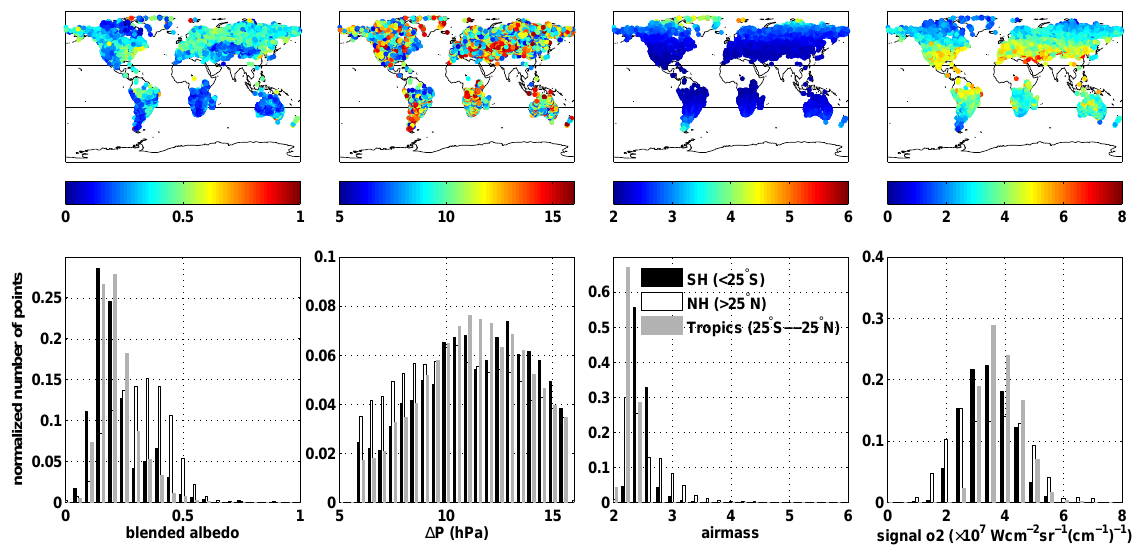
Fig. 8. A map and histogram of the parameters used in Eq. (4) in August. The horizontal black lines on the maps denote the 25° N and 25° S latitudes.